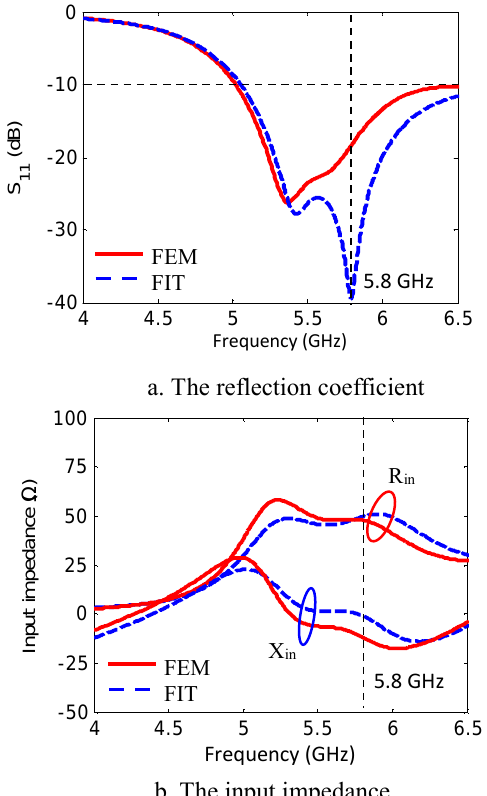
Fig.2. The reflection coefficient and the input impedance of the circularly polarized DRA element mounted on a cylindrical ground plane in free